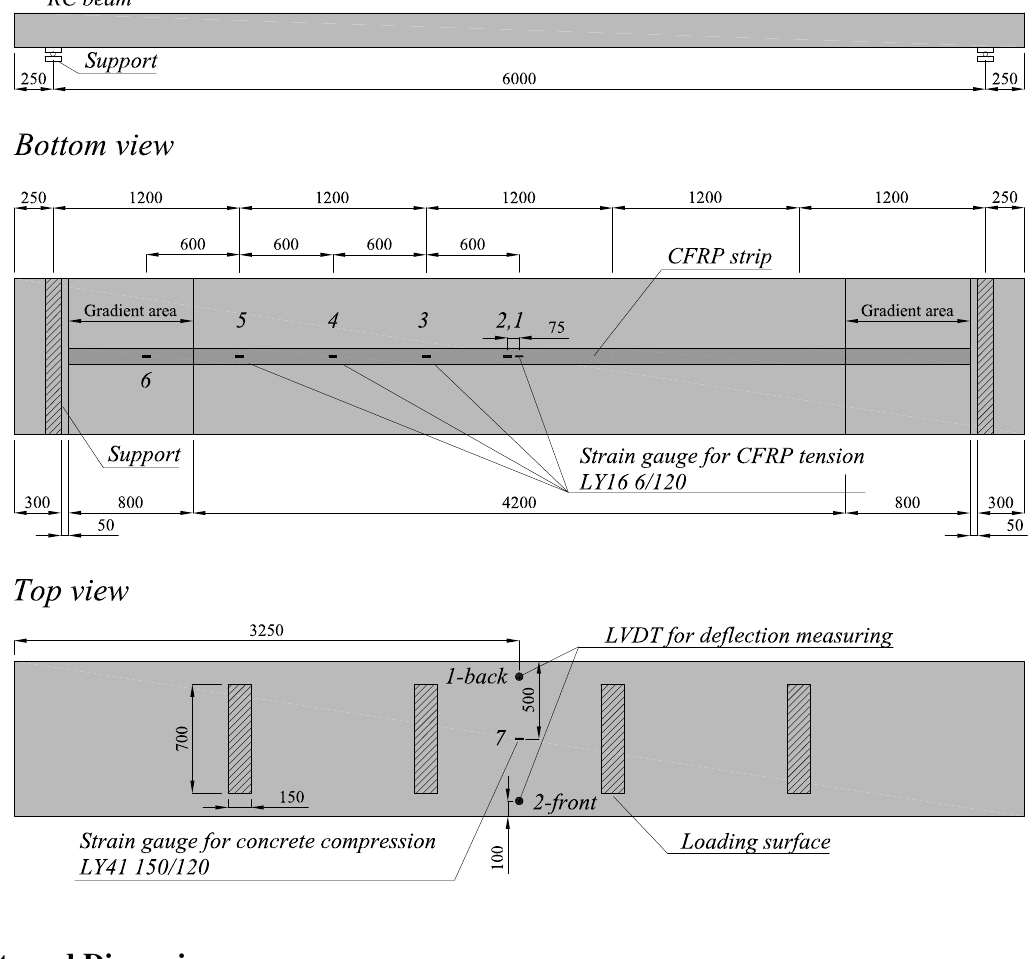
Figure 5. Measurement plan (dimensions in